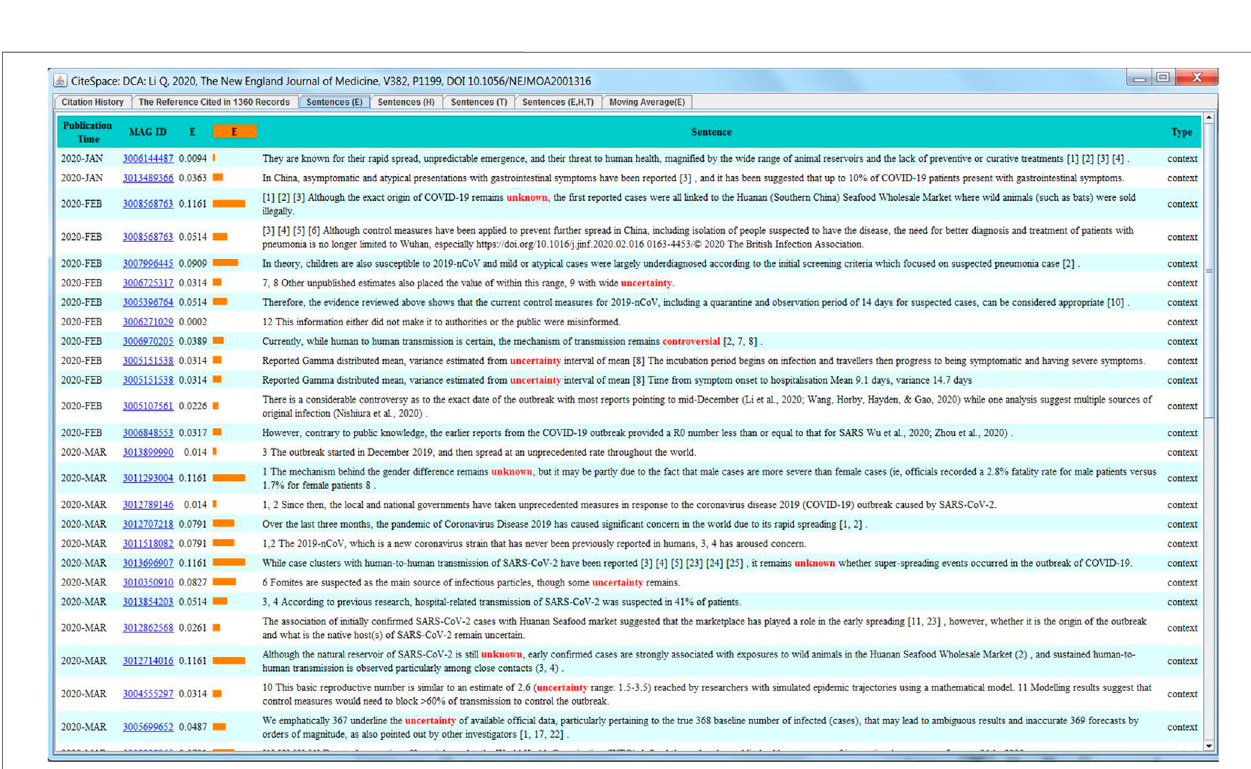
FIGURE 4 | Uncertainties of citation contexts of Li et al.